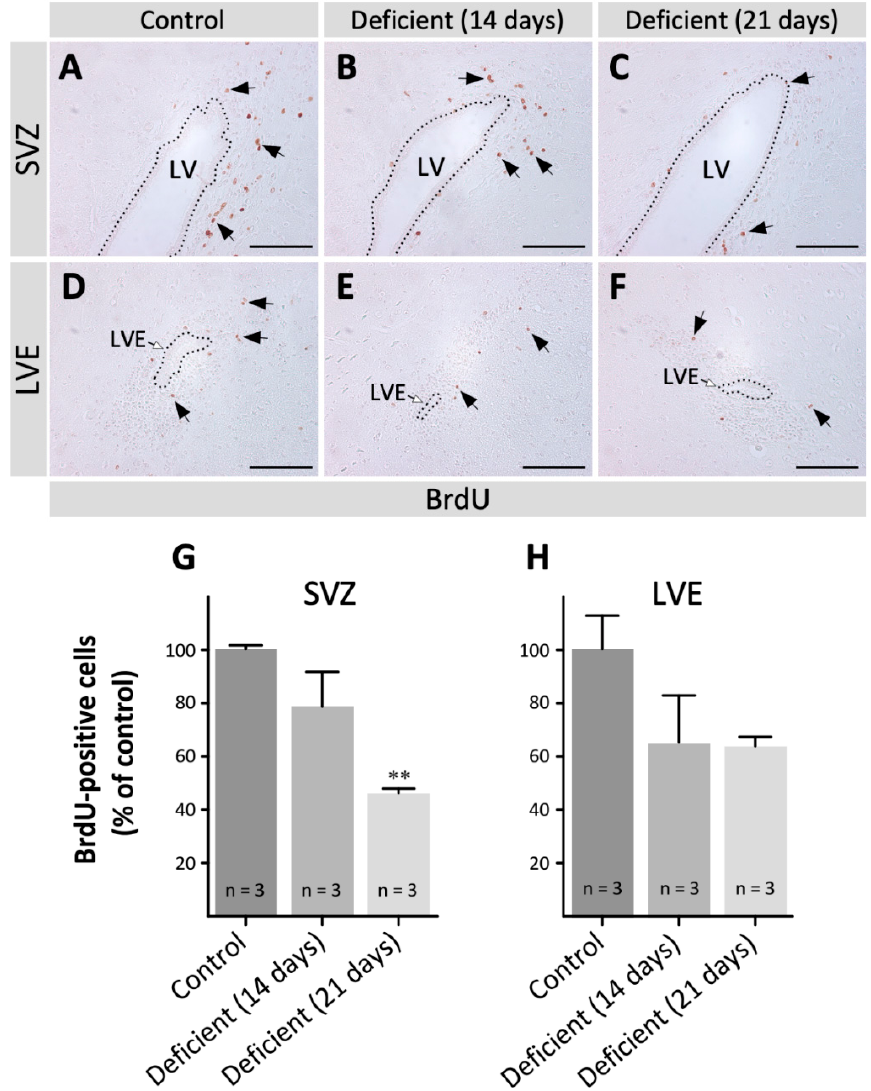
Figure 3. Analysis of BrdU-positive cells (B-type and C-type cells) in the brain of adult vitamin-C-deficient guinea pigs. Coronal sections of the brain of control guinea pigs ( A , D ) and the brain of guinea pigs with 14 ( B , E ) and 21 days ( C , F ) of vitamin C deficiency, labeled with anti-BrdU (1:200) as a proliferation marker. ( A – C ) In the SVZ, many BrdU-positive cells are observed in control animals ( A ) but they progressively decreased in guinea pigs with 14 ( B ) and 21 days ( C ) of vitamin C deficiency (arrows). ( D – F ) In the LVE, few BrdU-positive cells are observed in control animals ( D ) and even fewer in vitamin-C-deficient animals ( E , F , arrows). ( G , H ) BrdU-positive cells were quantified in the SVZ ( G ) and LVE ( H ); their number decreased in the condition of vitamin C deficiency. Data are presented as mean ± SD. Statistical analysis was performed using one-tailed ANOVA test and Bonferroni post-test; ** p < 0.01. n = 3. LV: lateral ventricle. LVE: lateral ventricle extension. SVZ: subventricular zone. Scale bar: 100 µ